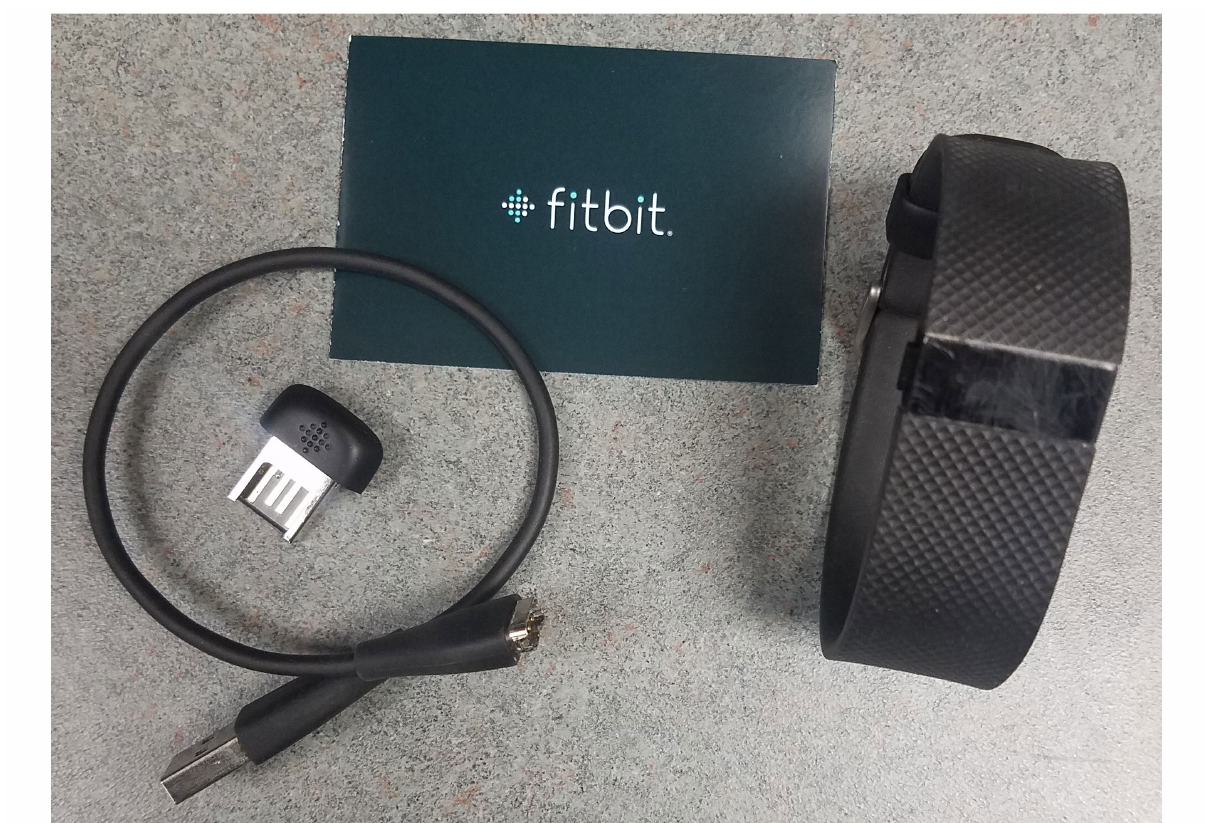
Figure 2. Fitbit Charge HR